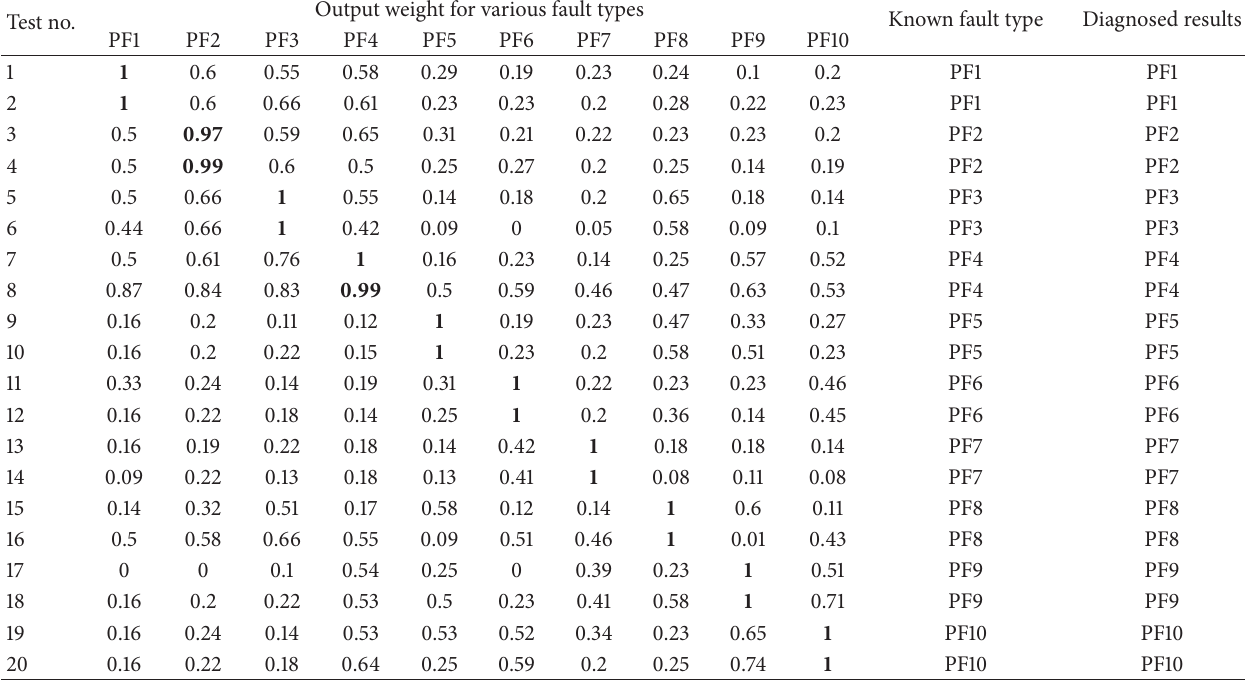
Table 5: Diagnosis results of the test data under 300–1000 W/m 2 irradiation and PV module surface temperatures between 31 and 40 ∘ C. Test